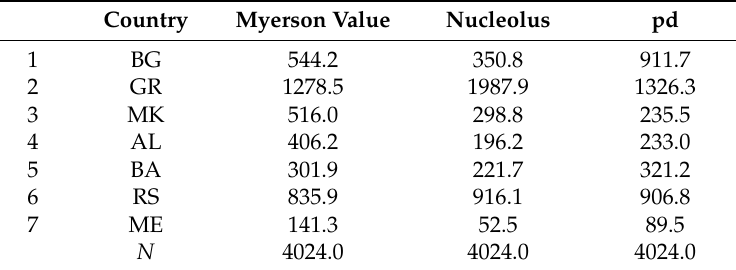
Table 7. Solutions for the 7-country game (in